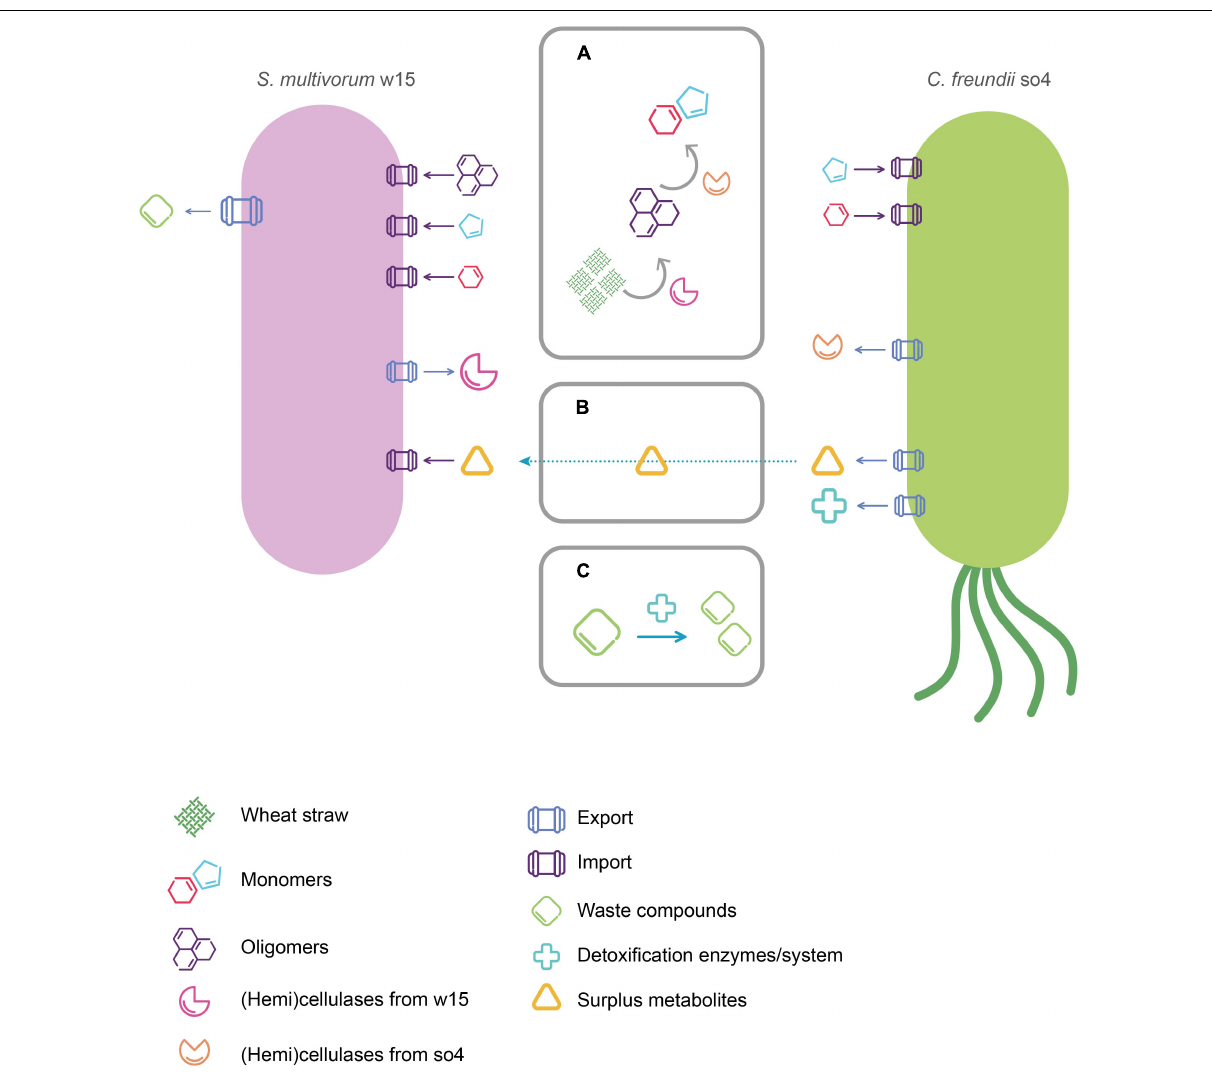
carboxyl esterases that carry out the deacetylation of